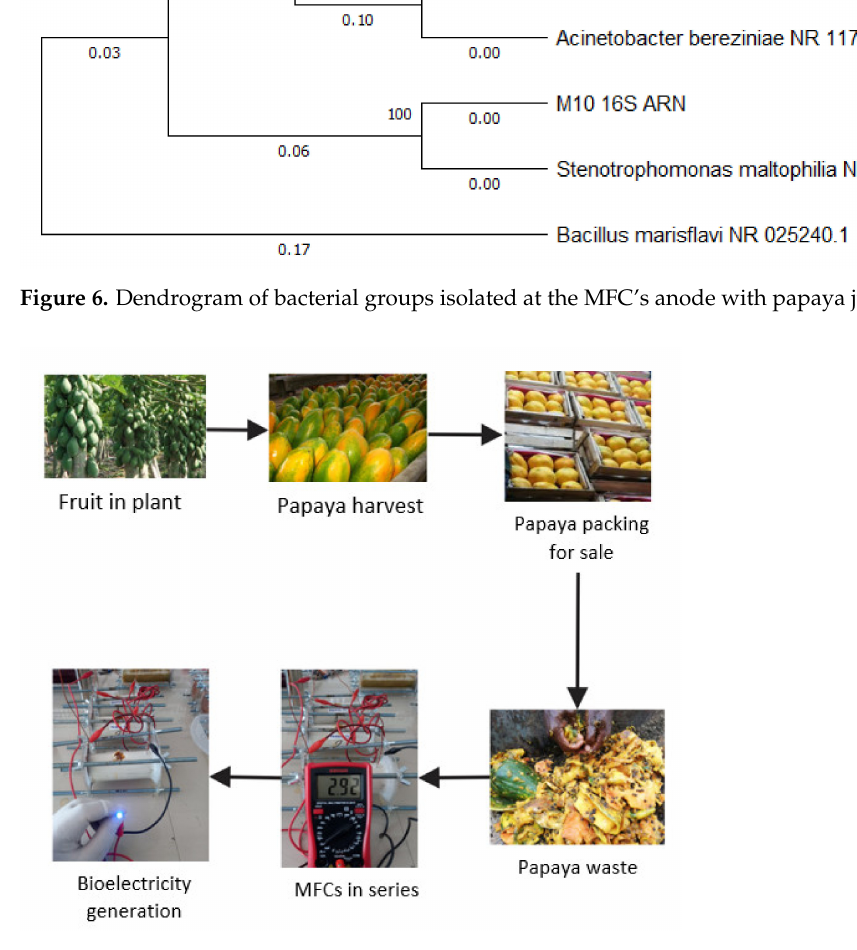
Figure 7. Scheme of Electricity Production by using MFCs with papaya waste in